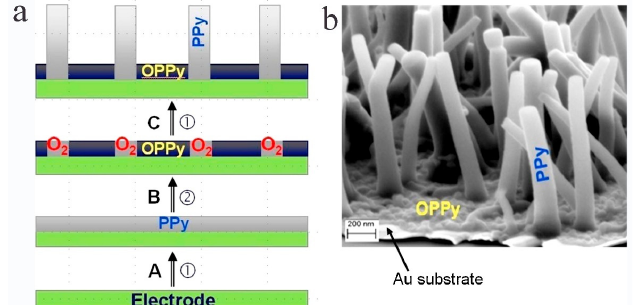
Figure 6. ( a ): Schematic model showing the process of PPy nanowire electrogeneration under potentiostatic conditions. Step A: Electrodeposition of an ultra thin PPy film. Step B: Generation of OH · which overoxidize PPy (OPPy) and of O 2 nanobubbles which protect PPy against the action of OH · . Step C: Growth of the PPy nanowires. Reaction (1): Py oxidation; Reaction (2): water oxidation. ( b ): SEM micrograph of PPy deposited on Au/mica substrate [121]. Copyright 2015 Electrochimica Acta.